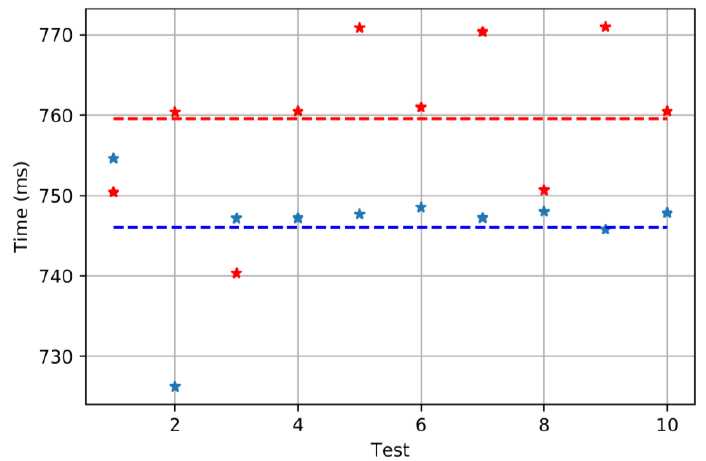
Figure 15. Steady state results when PFM and PWM are used. Ten tests are run for each modulation: in blue, the results for PFM, and, in red, for PWM. The average values are also shown: 746.01 ms for PFM and 759.58 ms for PWM. The set-point used was 180°.